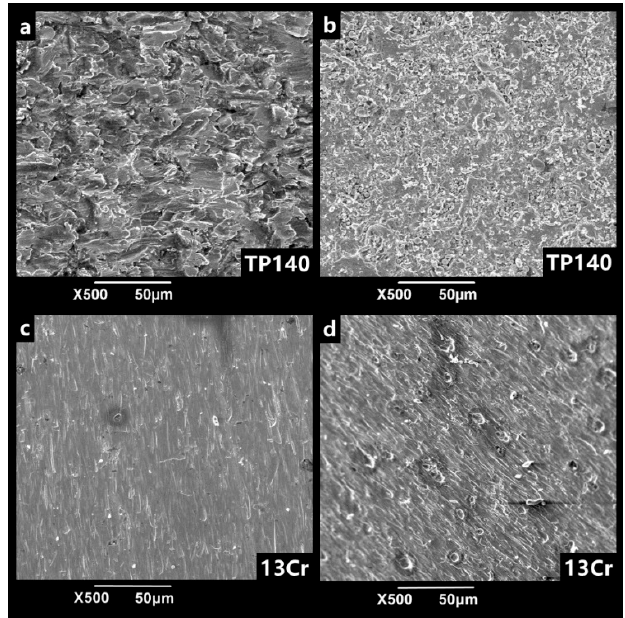
Figure 12. SEM images of erosion surface of TP140 and 13Cr before and after corrosion at the velocity of 8 m/s.